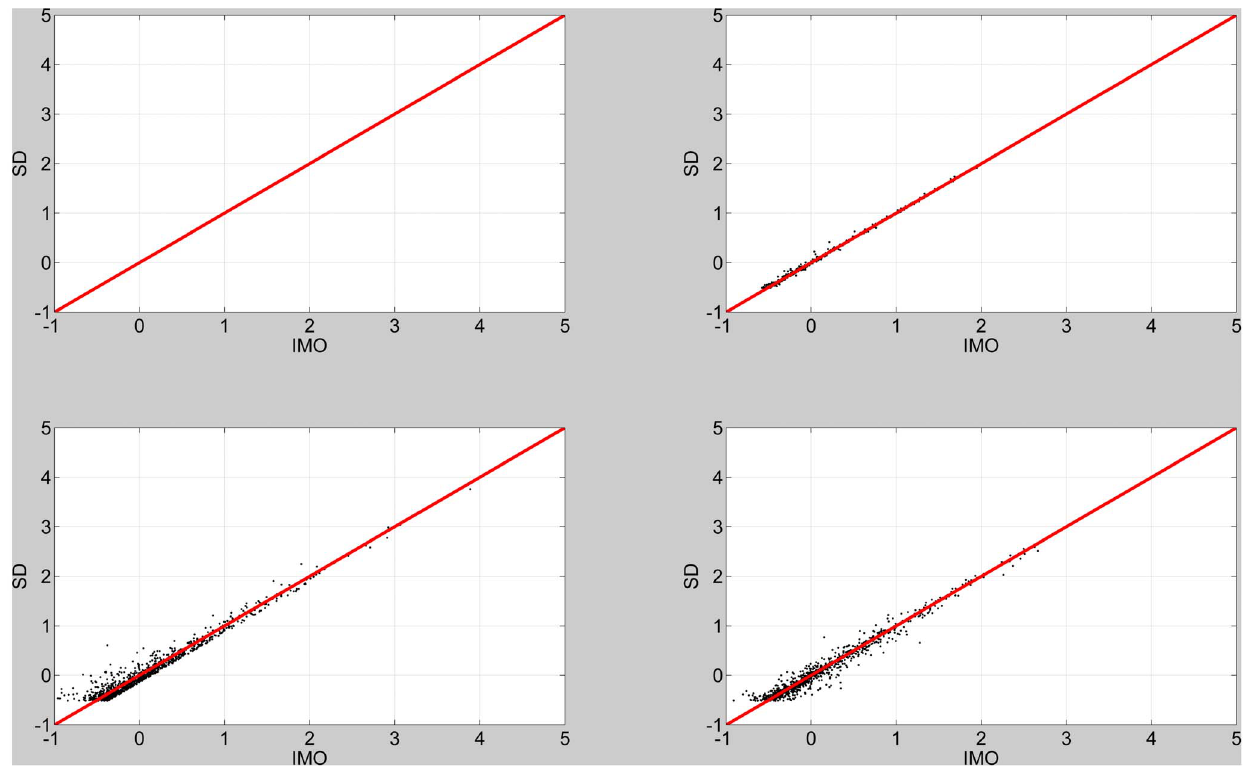
Figure 4. Second-level design. Savage-Dickey log Bayes factor versus IMO log Bayes factor for four levels of variability in prior precisions: 0% (top left), 17% (top right), 33% (bottom left) and 50% (bottom right). The red line denotes equality.